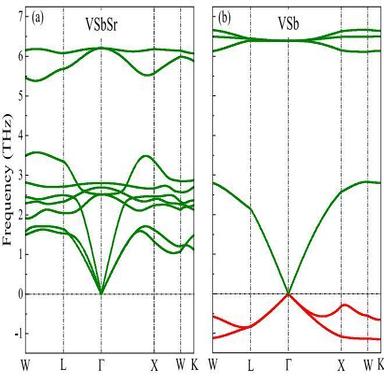
The phonon band structure of HH-VSbSr (a), and that of ZB-VSb (b), at the corresponding optimized lattice constants.